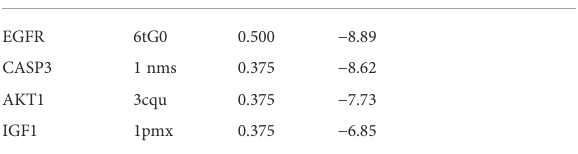
TABLE 1 Molecular docking